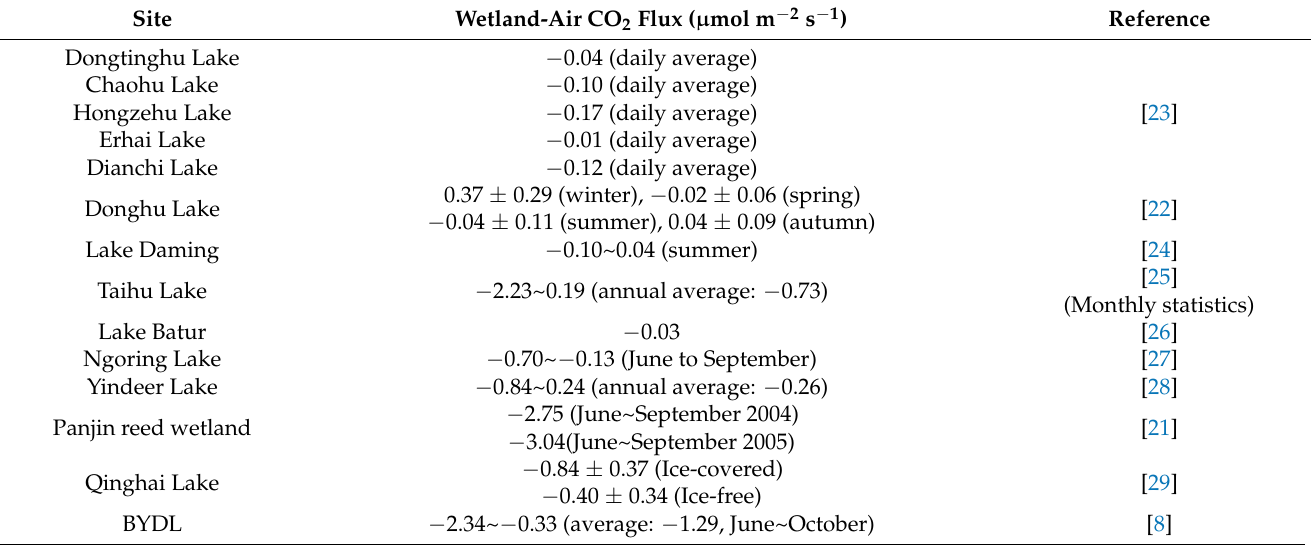
Table 3. Comparison of the wetland-air CO 2 absorption fluxes between the BYDL and other simi- lar